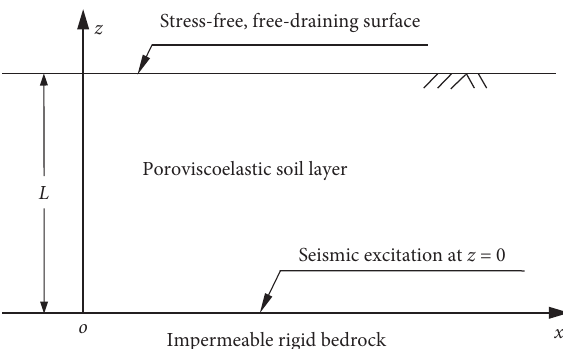
Figure 1: A viscoelastic soil layer subjected to vertical/horizontal earthquake excitation at rigid